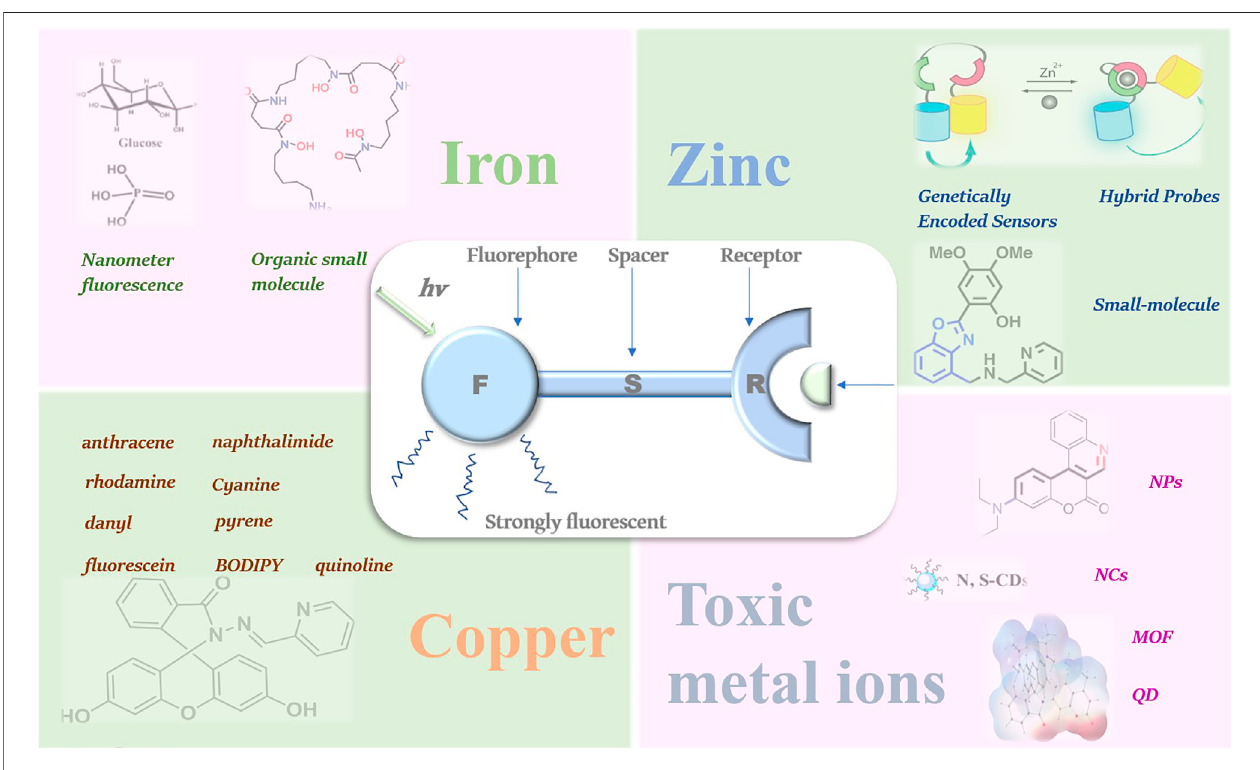
FIGURE 1 | Various types of fl uorescent probes for metal ion detection.